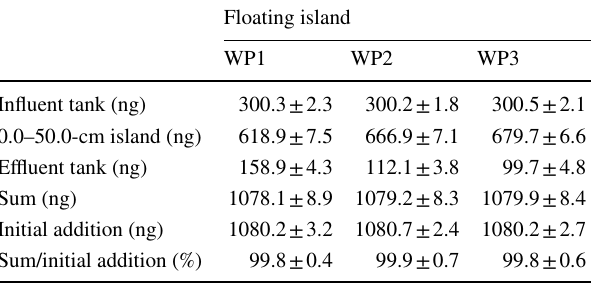
Table 4 Interception amounts of naphthalene in influent tanks, efflu‑ ent tanks and 0.0–50.0 cm‑length floating